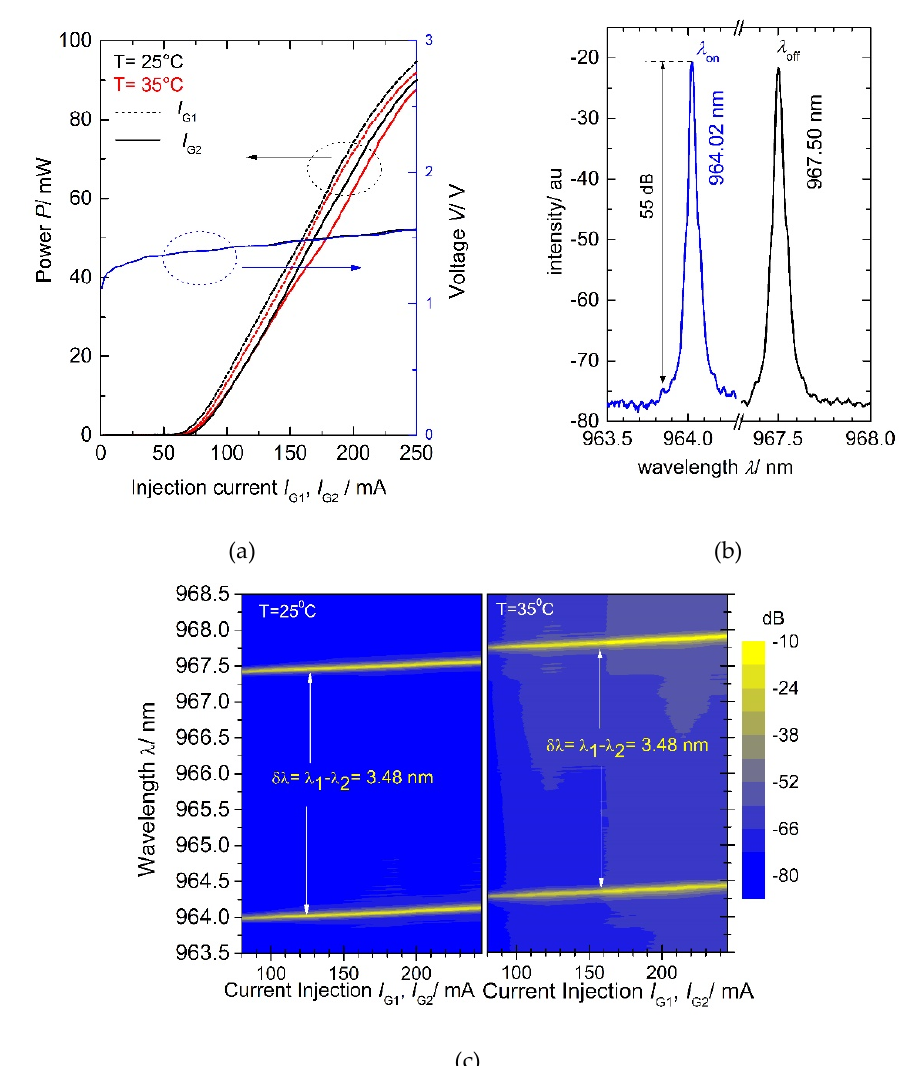
Figure 4. ( a ) CW optical output power (left axis) and voltage (right) versus the injection currents to the two branches of the Y ‐ DFB laser ( I G1 : dotted lines, I G2 : solid lines) at T = 25 °C (black) and 35 °C (red). ( b ) CW optical spectra of the two branches at currents of I G1 = I G2 = 130 mA at T = 25 °C. ( c ) Superimposed pseudo ‐ color mappings of CW optical spectra of the two branches in dependence on the injection currents at T = 25 °C (left) and T = 35 °C (right).